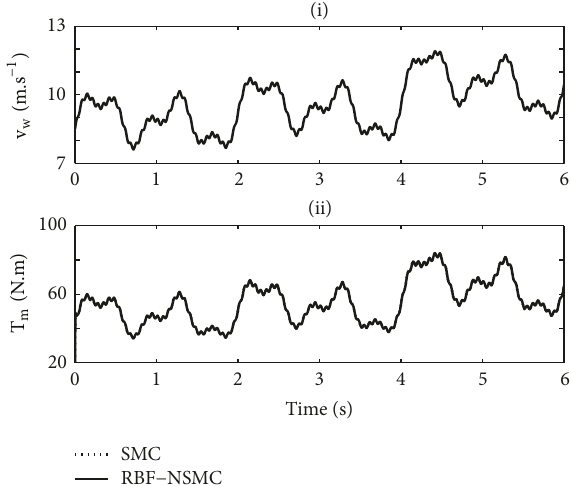
Figure 4: Wind speed profile and consequent mechanical